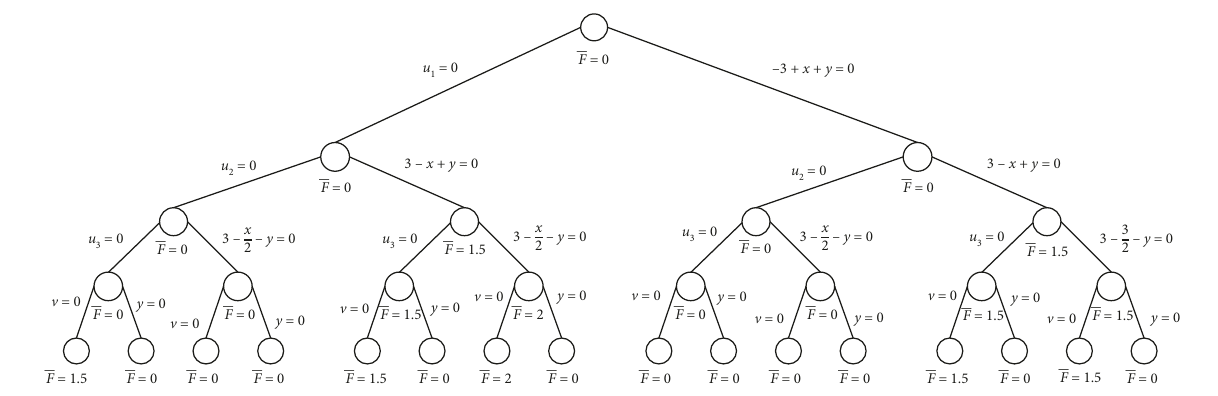
Figure 3: Search tree for Example 5.